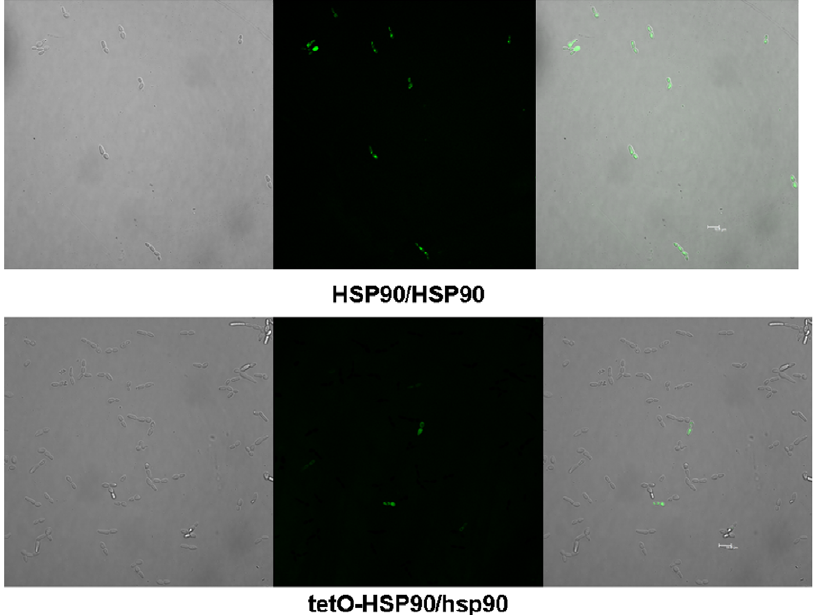
Figure 7. Representative confocal scanning laser fluorescence images of HSP90/HSP90 and tetO-HSP90/hsp90 cells stained for caspase activity following exposure to 5 mM H 2 O 2 for 3 h in the presence of DOX. Bar represents 10.8 m